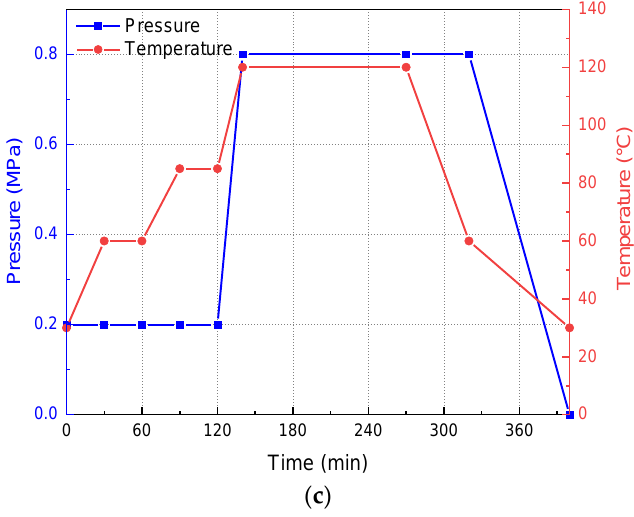
Figure 1. ( a ) Fabrication process; ( b ) manufacturing process for CFRP composite laminates; ( c ) hot- pressing process parameters.